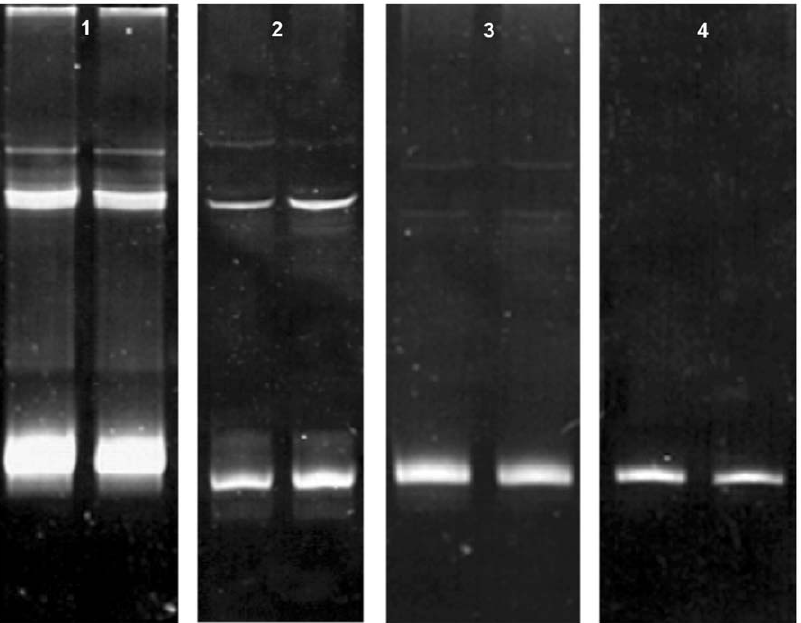
Figure 4. DGGE analysis for different primer concentrations of a single HPR7b variant. Duplicate reactions: Lane 1: 25 nM, lane 2: 20 nM, lane 3: 18.6 nM, lane 4: 12.5 nM.